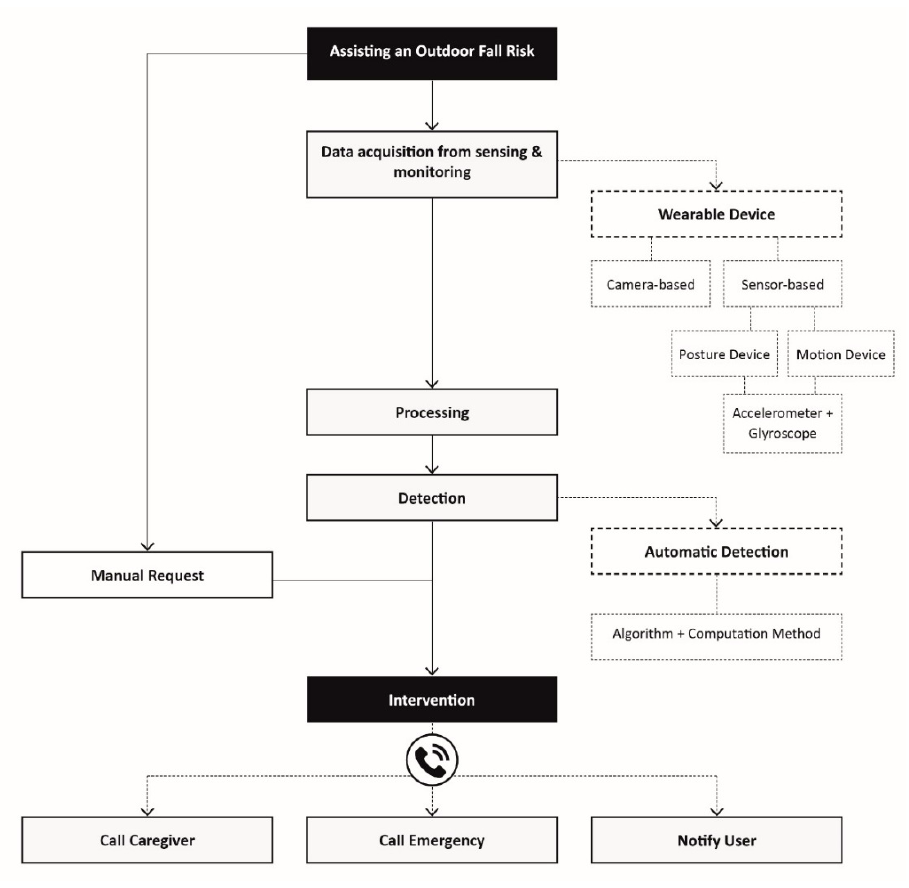
Figure 5. Assistive technology framework for fall risk. (Adapted from Yared et al. [34]).